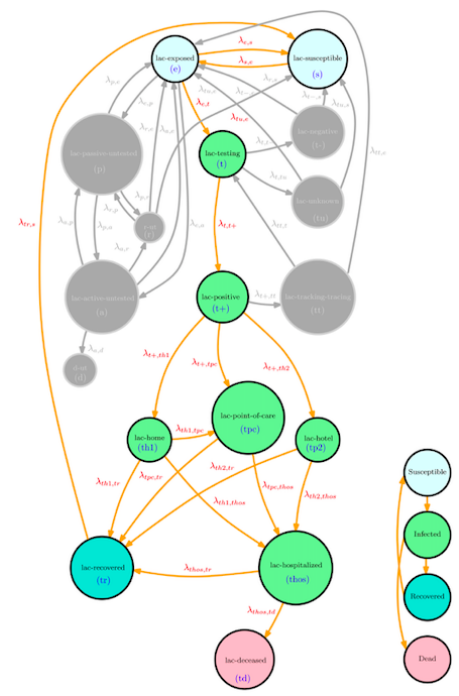
Figure 10. Connection of the dynamics of SIRD.